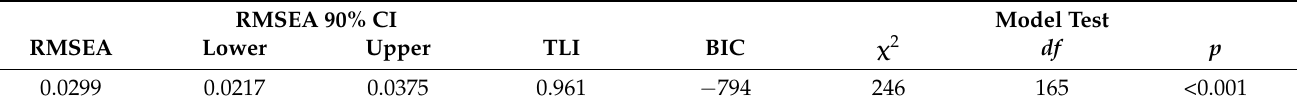
Table 2. Model fit Table 2. Model fit measures.